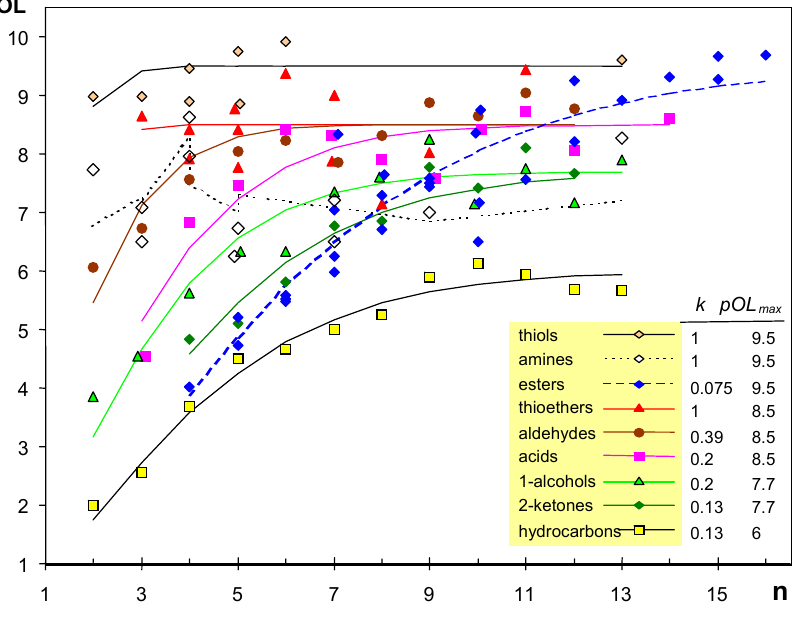
Figure 1. Plot of pOL versus n (number of atoms except hydrogens) for 114 aliphatic compounds. Equations in Table 1 have been fitted for each homologous series. Estimated and k (coefficients of Equation (4)) are indicated within the values of pOL max